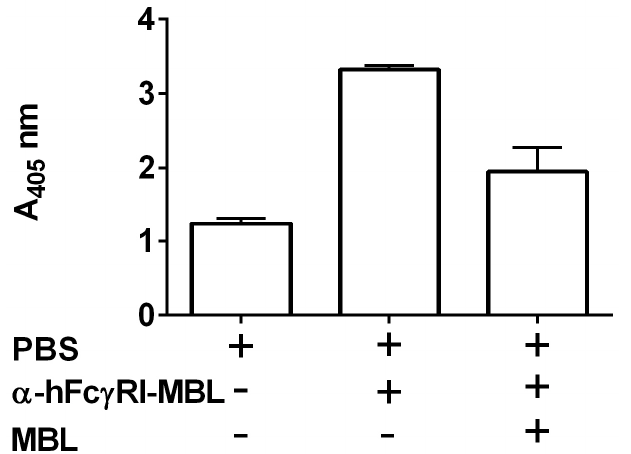
Figure 5. Binding of α -hFc γ RI-MBL with inactivated SARS-CoV-2: ELISA plates were coated with inactivated SARS-CoV-2 overnight and blocked with 5% BSA. PBS, α -hFc γ RI-MBL, and MBL were added in appropriate wells and incubated for one hour at 4C. The binding of α -hFc γ RI-MBL was evaluated by sequential treatment with anti-MBL antibody and alkaline phosphatase-conjugated secondary antibody. Result: In comparison with PBS, the increase in ELISA signal with α -hFc γ RI- MBL indicates binding of the fusion protein to inactivated SARS-CoV-2, while the reduction in signal in the presence of MBL signifies specificity of binding.